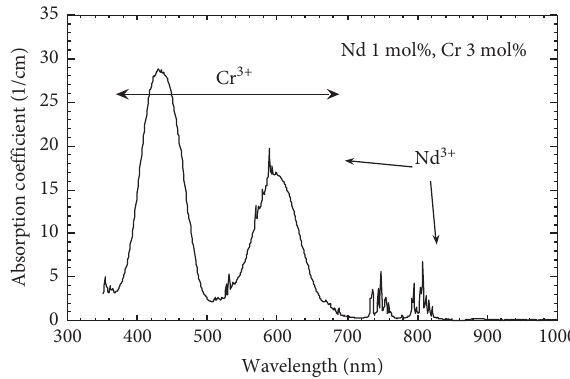
Figure 3: Absorption spectrum of the Nd/Cr:YAG